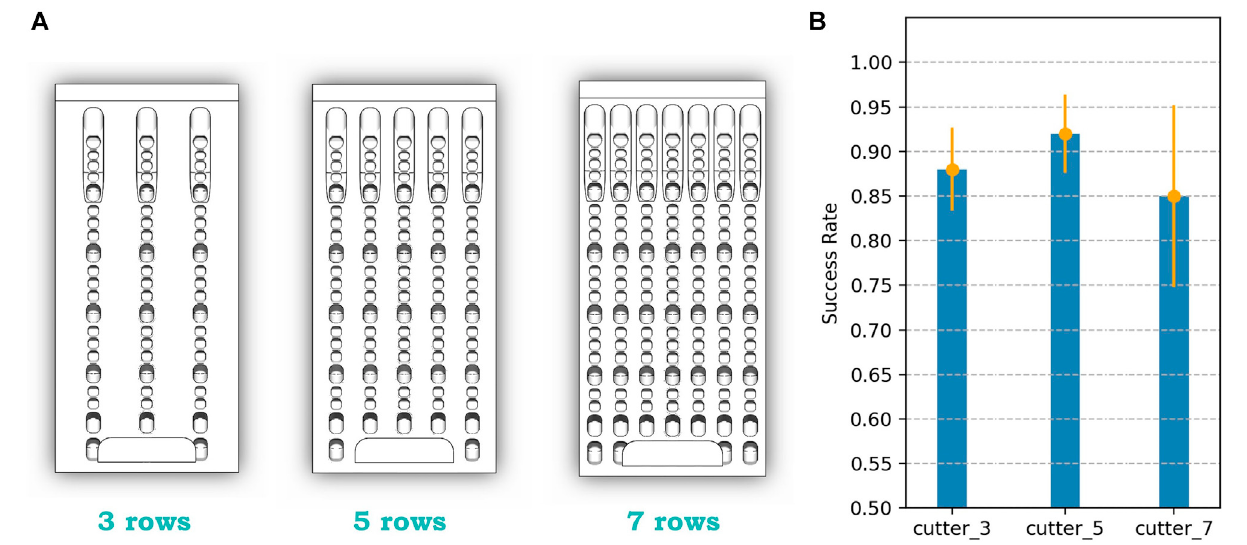
FIGURE 9 | Second iteration designs and their performance, with mean and variance.